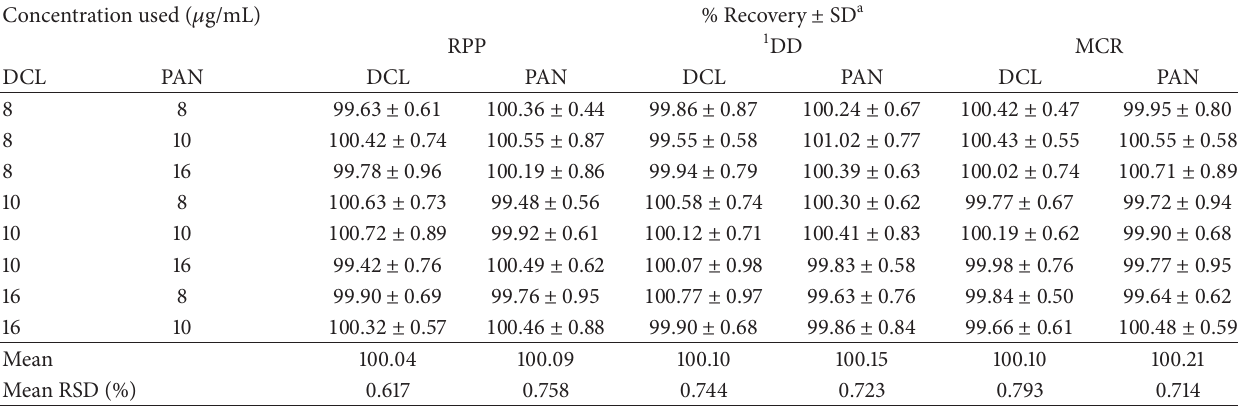
Table 3: Summary for the determination of diclofenac (DCL) and pantoprazole (PAN) in laboratory prepared mixtures by the proposed methods.